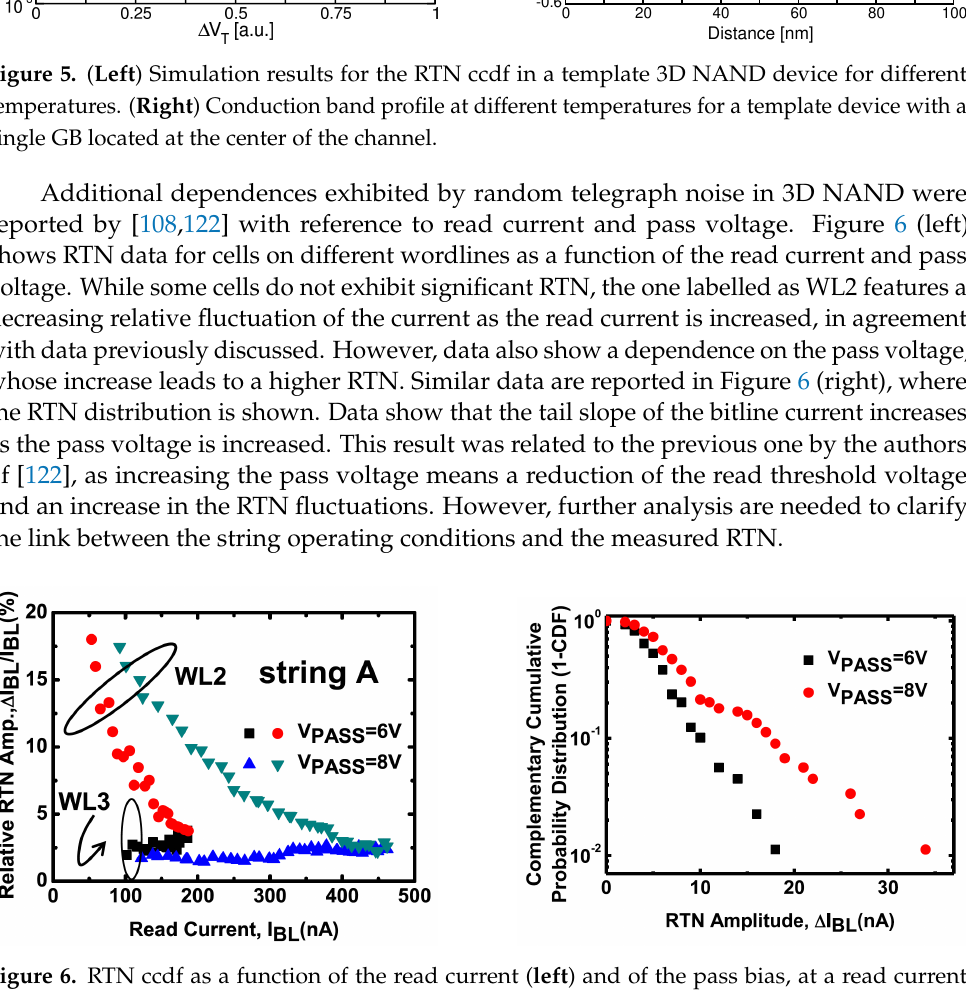
Figure 6. RTN ccdf as a function of the read current ( left ) and of the pass bias, at a read current of 100 nA ( right ). From [122], © 2016,